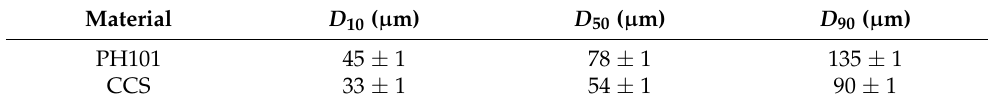
Table 2. Particle size distribution of the two materials (obtained from [32]).